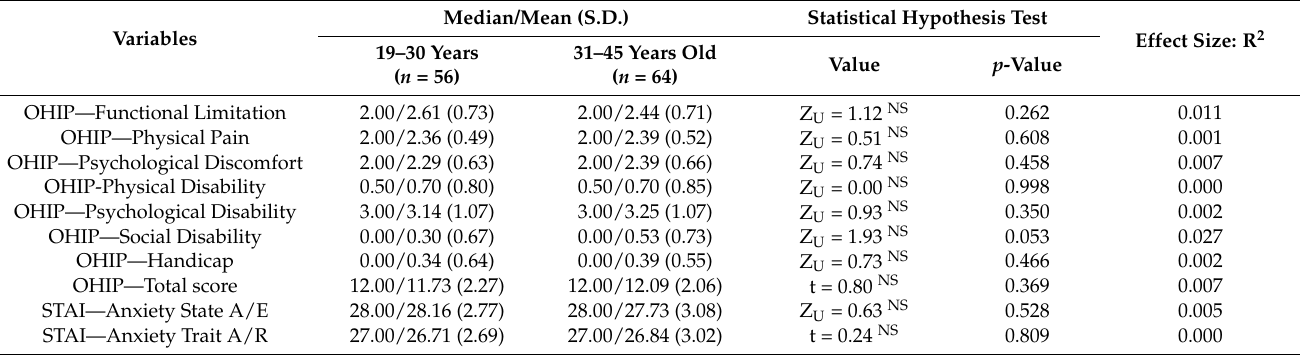
Table 4. Inferential Analysis. Intergroup comparison of OHIP-14 and STAI variables based on age ( n =